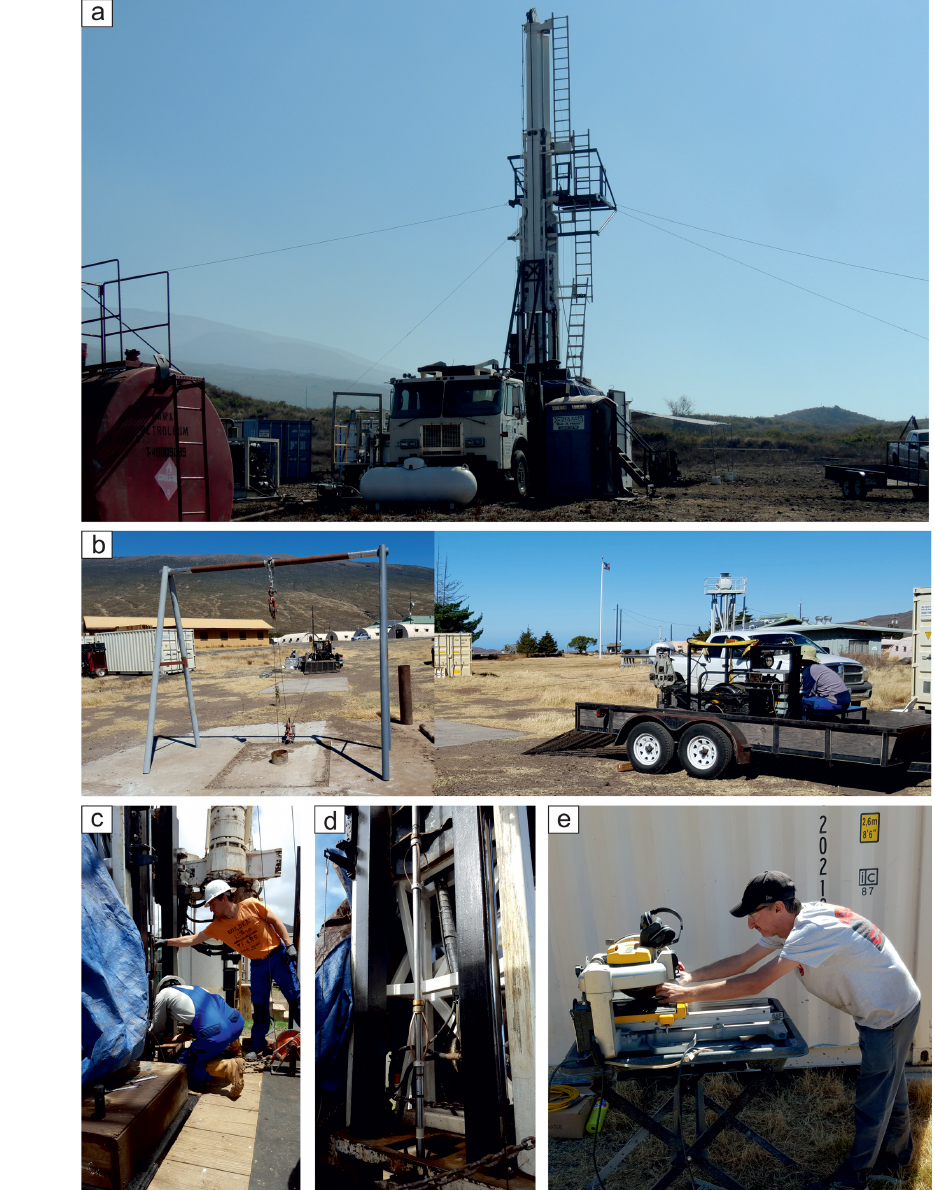
Figure 2. (a) Drill truck at the KMA1 site. (b) Spectral gamma logging within casing at PTA2. (c) Jochem Kück and Marco Groh (GFZ) with the sonic sonde at PTA2. (d) Borehole televiewer sonde being lowered into the borehole at PTA2. (e) Eric Haskins cuts sections of core for additional